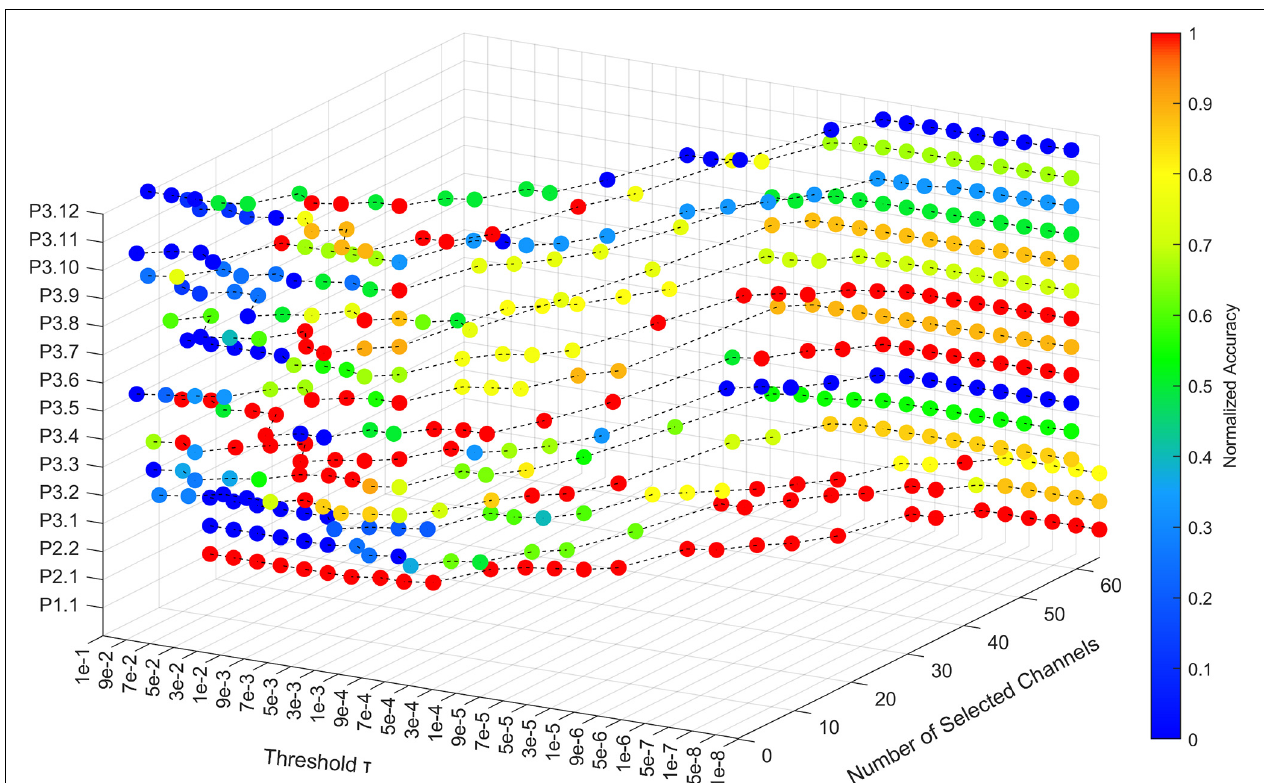
FIGURE 6 | The effect of shear threshold τ in RSBSBL on the number of selected channels and accuracy. The x -axis indicates the number of selected channels, the y -axis indicates the value of τ , and the z -axis indicates the participant ID. The color of the sphere represents the normalized recognition accuracy for each participant with different